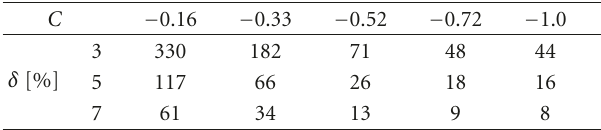
( Θ ∗ ) and C . peak Table 4: Number of necessary grains m ∗ (Confidence value: